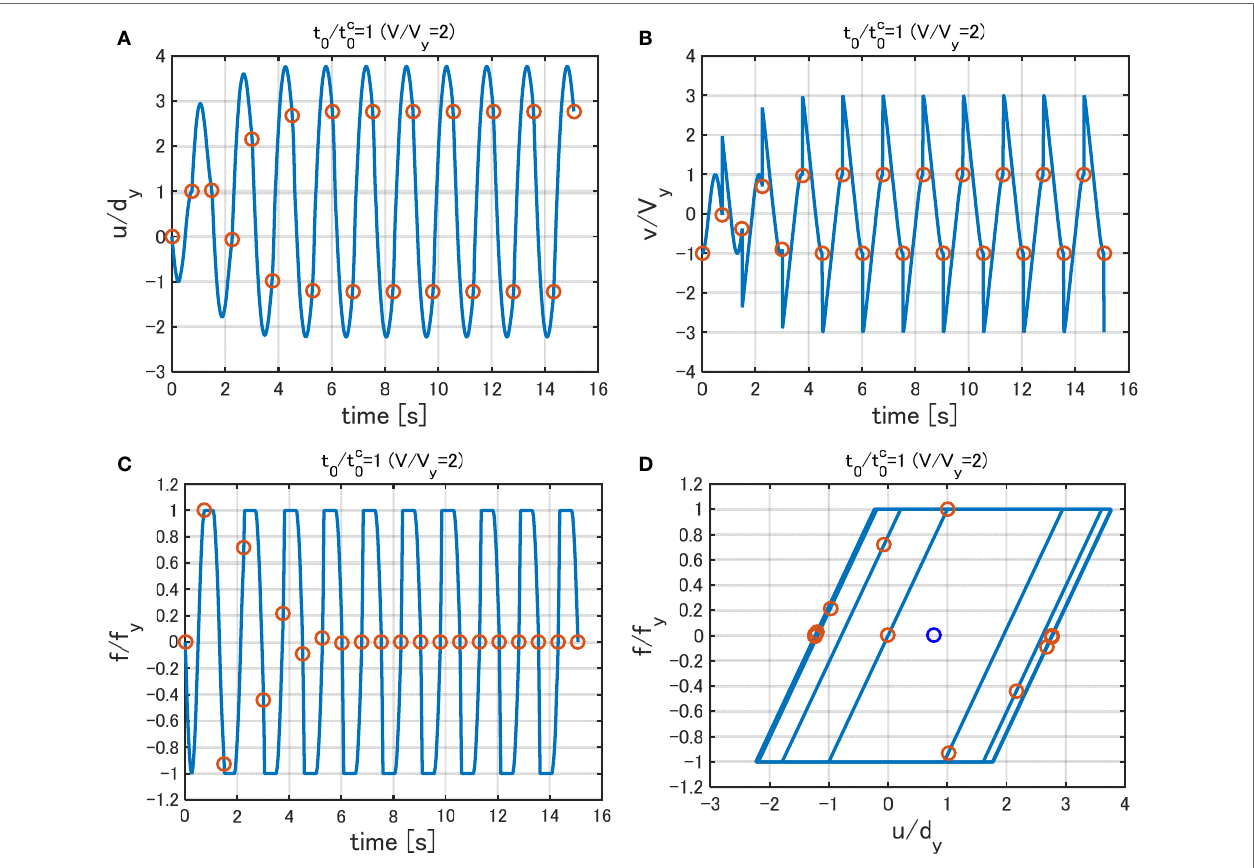
FigUre 7 | response to input sequence 1 for V / V y = 2 (impulse timing is the critical one obtained by using the input sequence 2): (a) displacement, (B) velocity, (c) restoring force, and (D) force–deformation relation